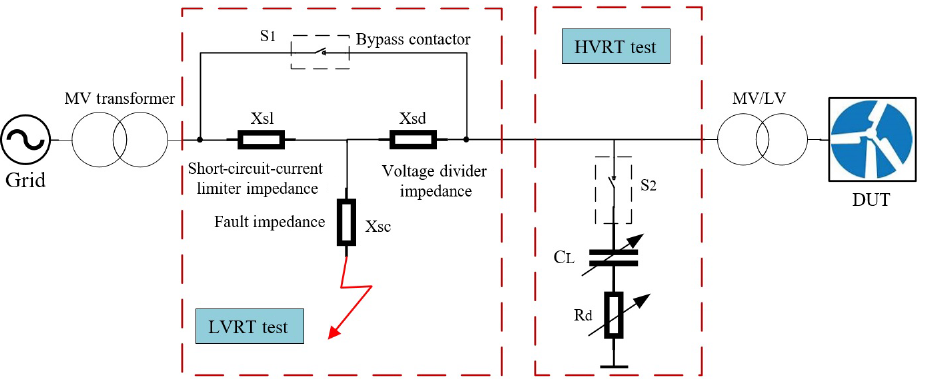
Figure 1. The basic structure of impedance-based topology for LVRT and HVRT capability tests (Ausin et al., 2008; Langstadtler et al., 2015).